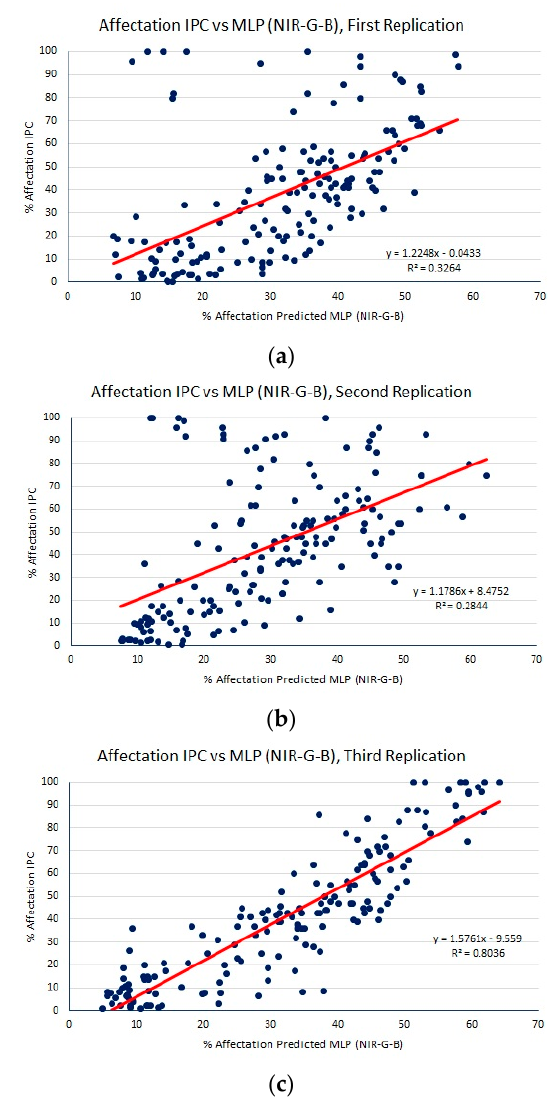
Figure 5. Percentage of P. infestans affectation using IPC methodology vs. estimated percentage of affectation using MLP on the NIR-G-B multispectral dataset, for ( a ) first replication, MAE: 16.50, RMSE: 23.74, R 2 : 0.3264; ( b ) second replication, MAE: 19.00, RMSE: 28.03, R 2 : 0.2844; ( c ) third replication, MAE: 13.63, RMSE: 18.00, R 2 : 0.8036. IPC: International Potato Center; MLP: Multilayer